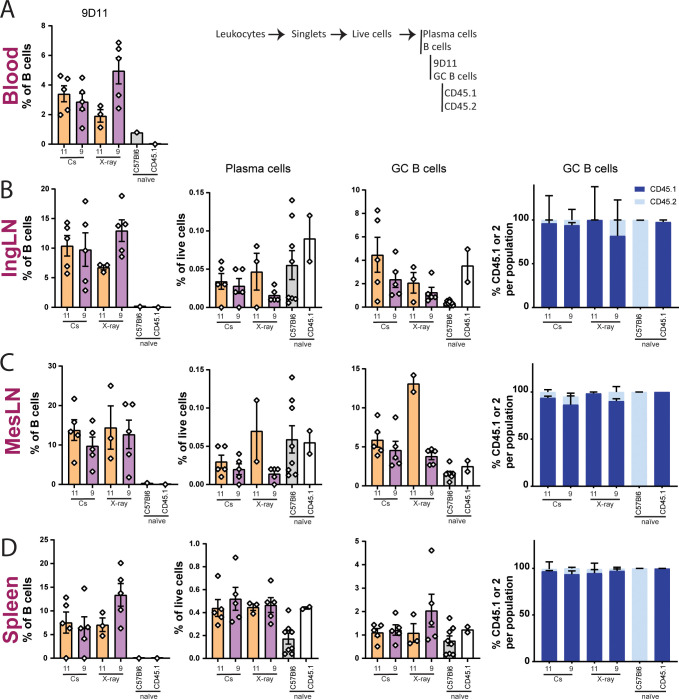
Autoimmune hallmarks in the mixed bone marrow chimeras are independent of irradiation method.Percentages of immune cells in blood (A), IngLN (B), MesLN (C) and spleen (D) after irradiation at doses of 9 and 11 Gy using either X-ray or Cs-137 irradiation, and fractional representation of CD45.1 vs. CD45.2 cells within GC B cells of IngLN, MesLN and spleen. Naïve mice have not been exposed to any treatment. Gating layout can be seen in S3 Fig. In all bar graphs, the bar indicates the mean and error bars indicate the standard error of mean. For MesLN cell frequencies, Kruskal-Wallis test indicated significant differences between medians within GC B cells (P = 0.0322), but with no significant differences for Dunn’s pairwise comparison for any of the groups. For relative representation of CD45.1 vs. CD45.2 cells, two-way ANOVA did not identify irradiation modality as an independent source of variation in the data for any of the tissues analyzed, although there was a significant interaction effect (P<0.0001 in all cases).